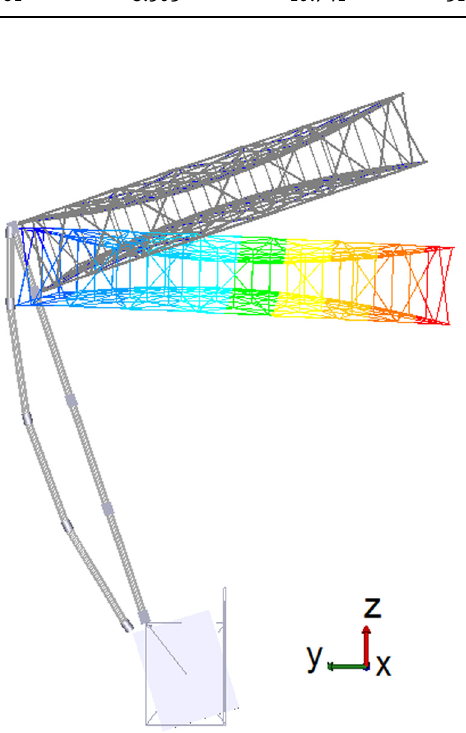
Figure 12: Second mode shape of the SSAR.